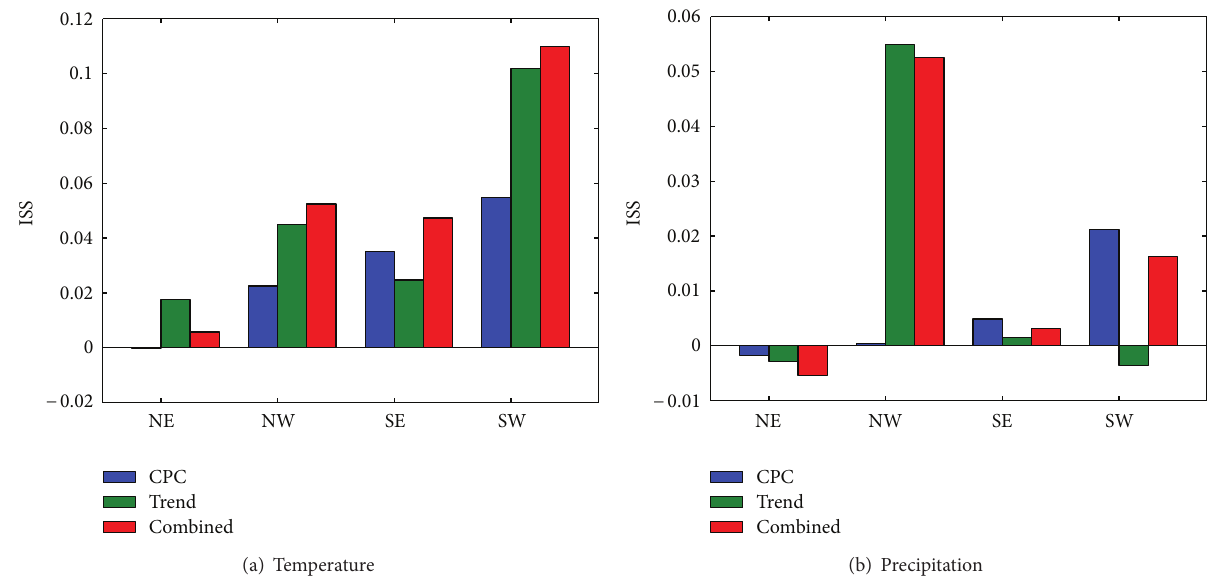
F 6: Mean information skill score by quarter of the USA for forecasts of (a) temperature and (b) precipitation.